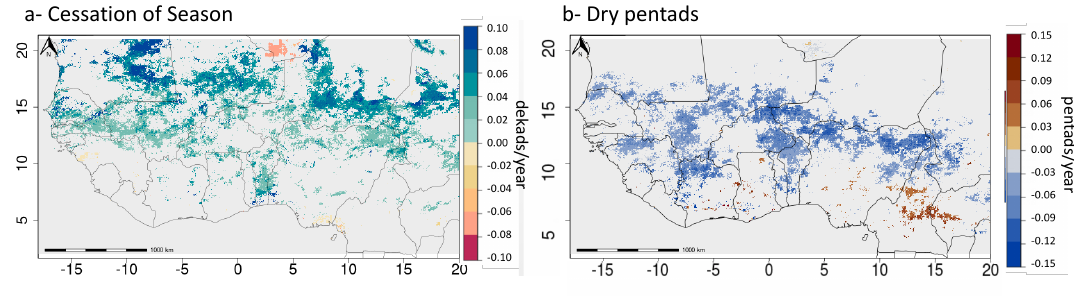
Figure 3. ( a ) Trend for the cessation of the season, as measured by dekads per year, calculated from 1981 to 2016. Capped at − 0.1 to 0.1 dekad/year, insignificance ( p > 0.05) is masked out in gray. ( b ) The trend of total number of dry pentads for the season, as measured in pentads/year, calculated from 1981 to 2016. Capped at − 0.15 to 0.15 pentads/year, insignificance ( p > 0.05) is masked out in gray. 3.2. ET